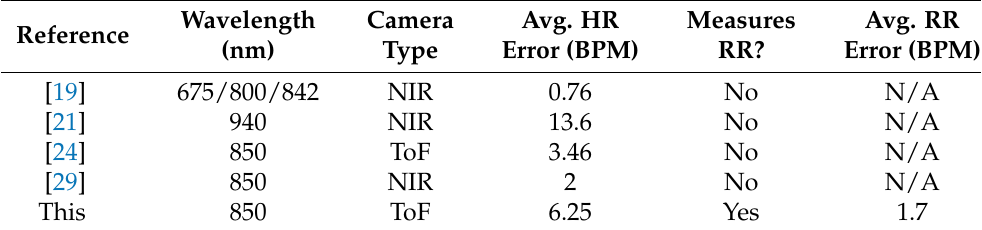
Table 2. Summary of recent studies on IR camera-based HR/RR monitoring